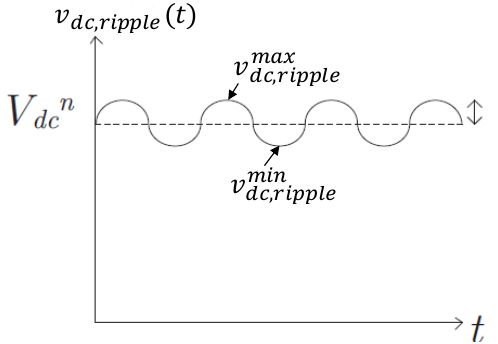
Figure 1. Generic DC link voltage waveform.